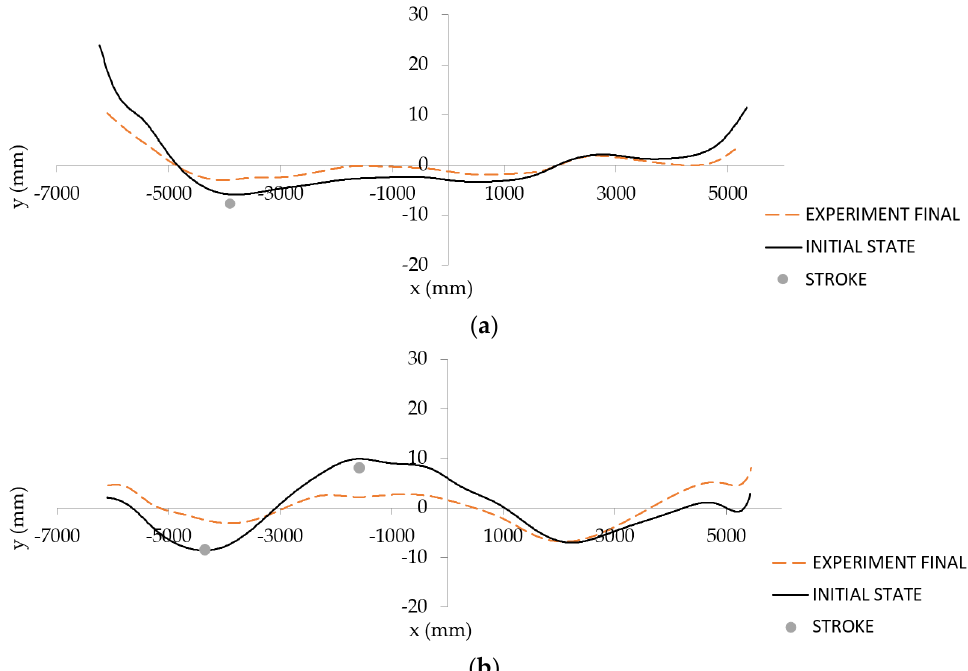
Figure 13. Initial and final shapes of two exemplary billets from operational experiments: “single-arc” type ( a ) and “S-shaped” type ( b ).